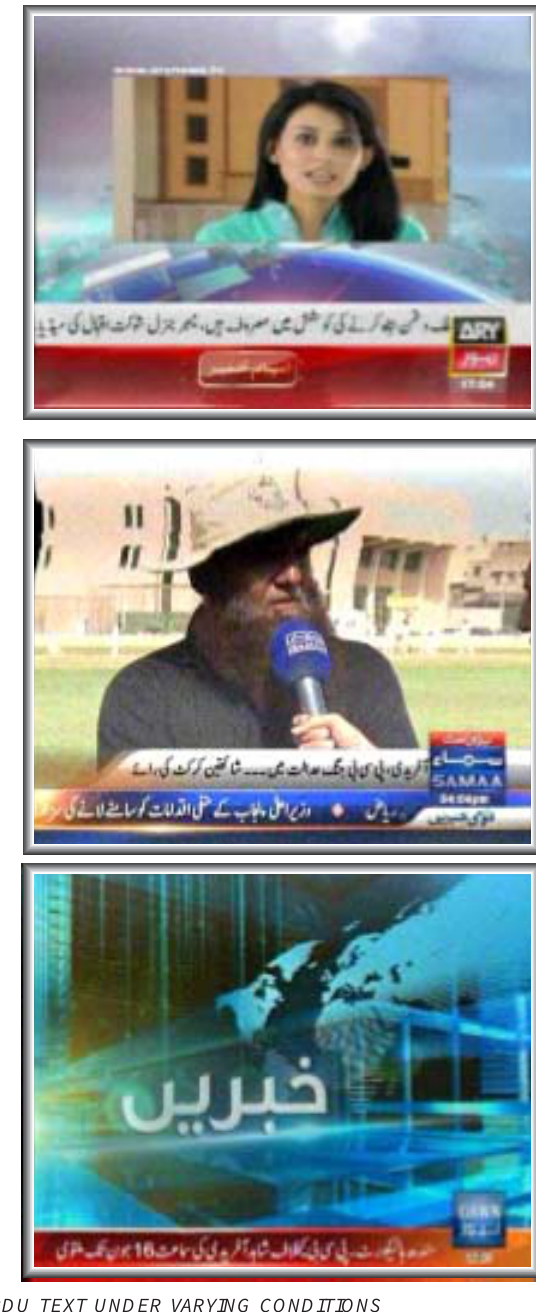
FIG. 1. SAMPLE IMAGES OF ARTIFICIAL URDU TEXT UNDER VARYING